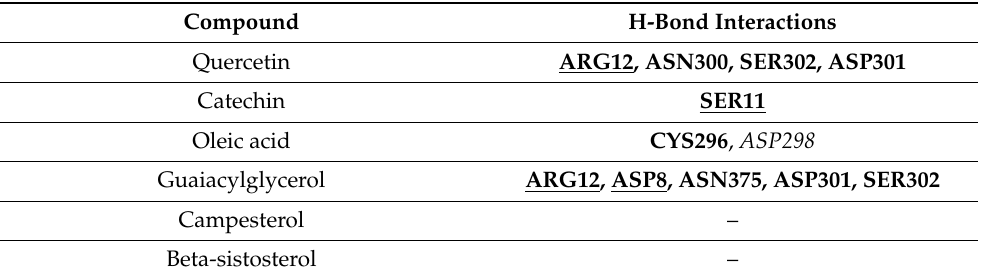
Table A1. Pinh ã o compounds that interacted with PACAP+PAC1 key residues according to docking